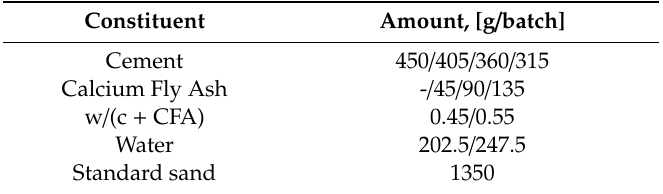
Table 6. Composition of mortars for testing the rheological properties.